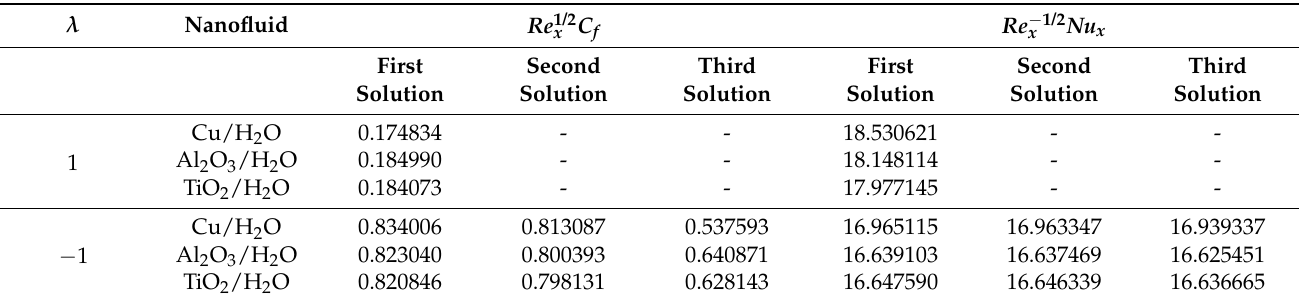
Table 4. Values of Re 1/2 x C f and Re − 1/2 x